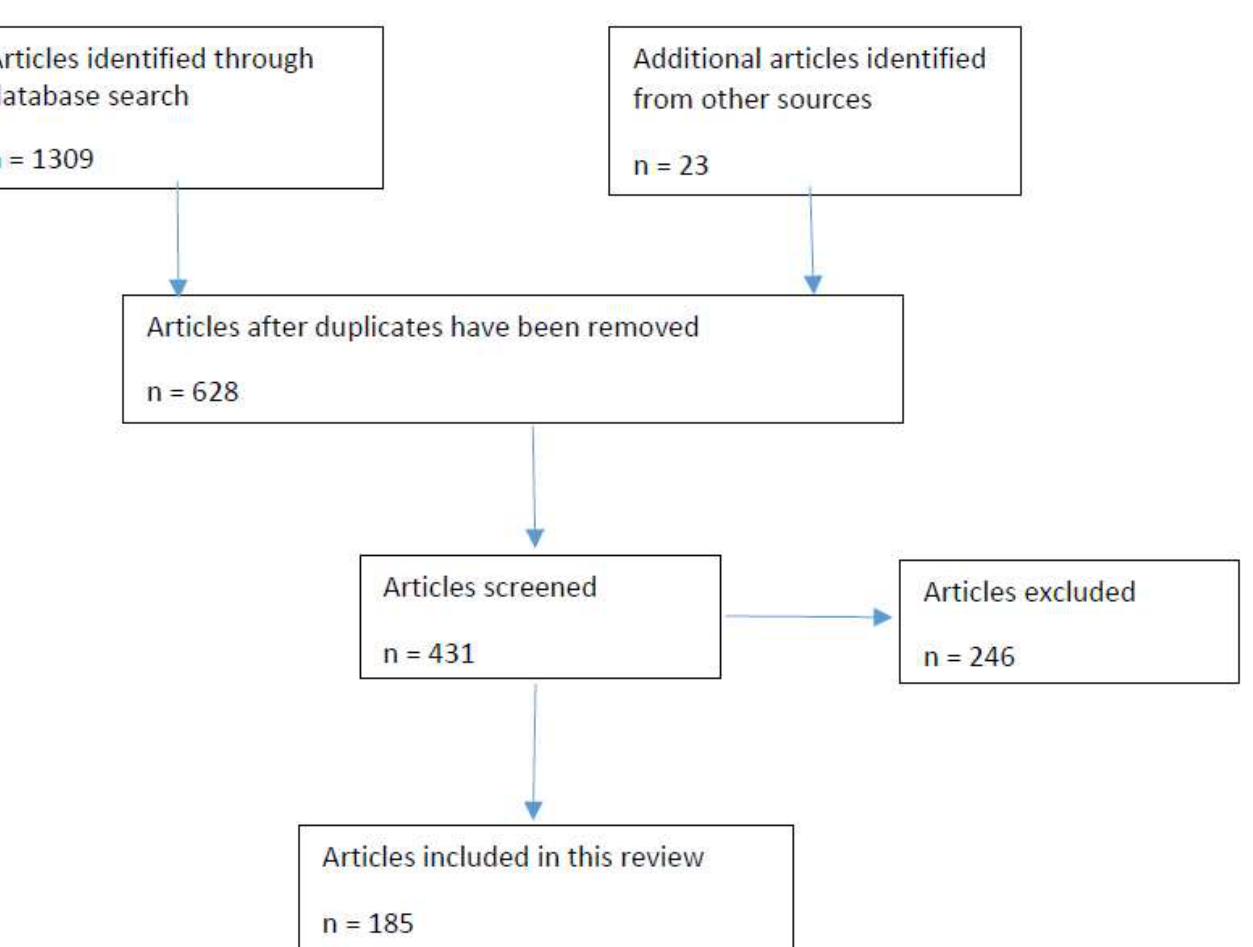
Figure 1. Flow diagram showing the identification and screening of the articles used in this re- view.